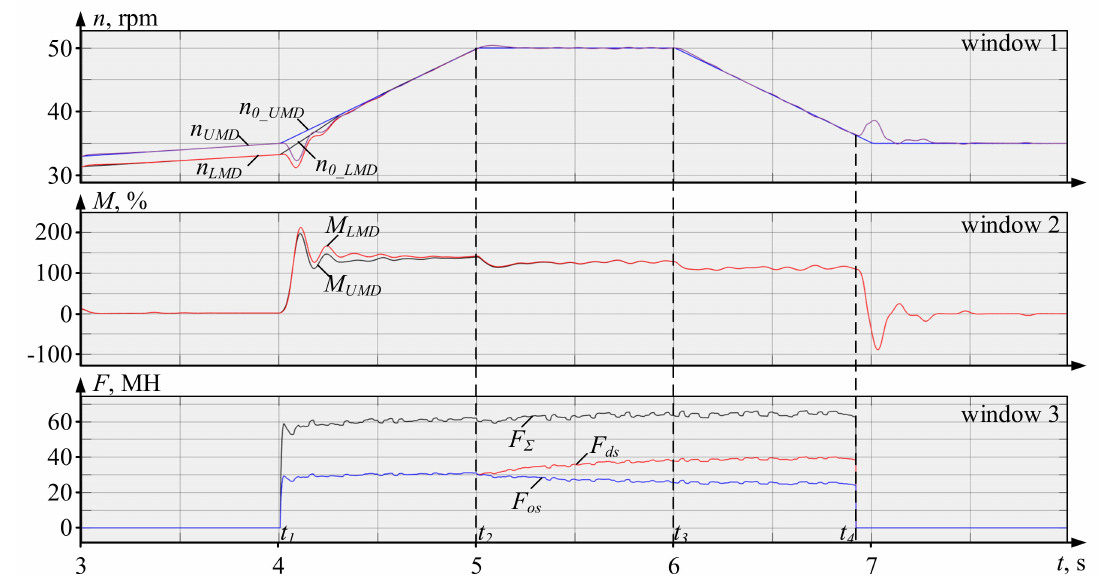
Figure 12. Simulation of roll gap misalignment compensation on a real drive tachogram: Panel 1 shows the speed signals ( n 0_UMD , n 0_LMD ) and actual speeds ( n UMD , n LMD ) of the drives; Panel 2 shows UMD and LMD torques; Panel 3 shows the side-specific forces F DS , F O S and the total force F Σ